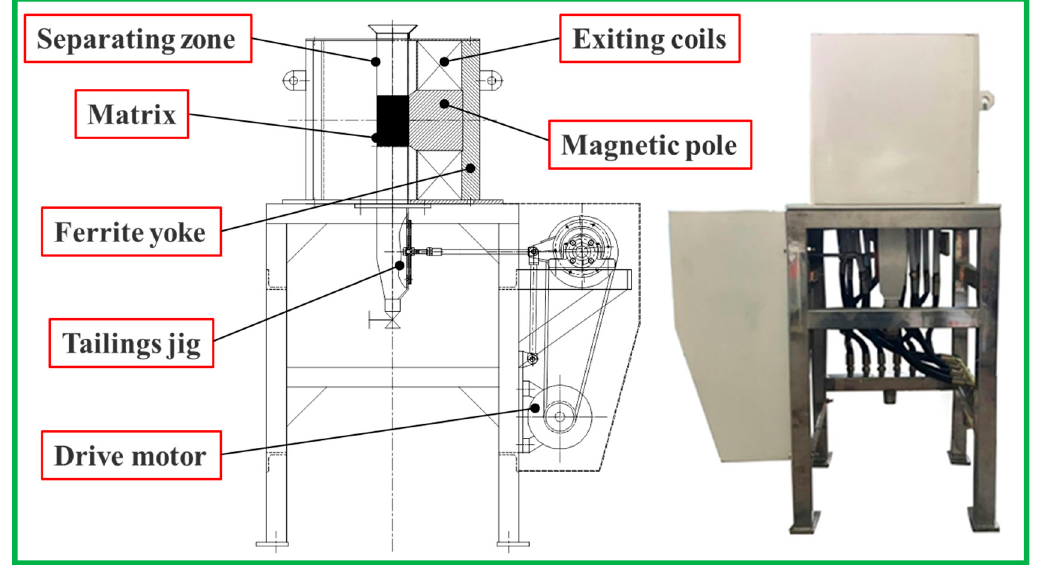
Figure 2. The structure schematic drawing of the cyclic horizontal magnetic field orientation high-gradient magnetic separation (HGMS) separator.